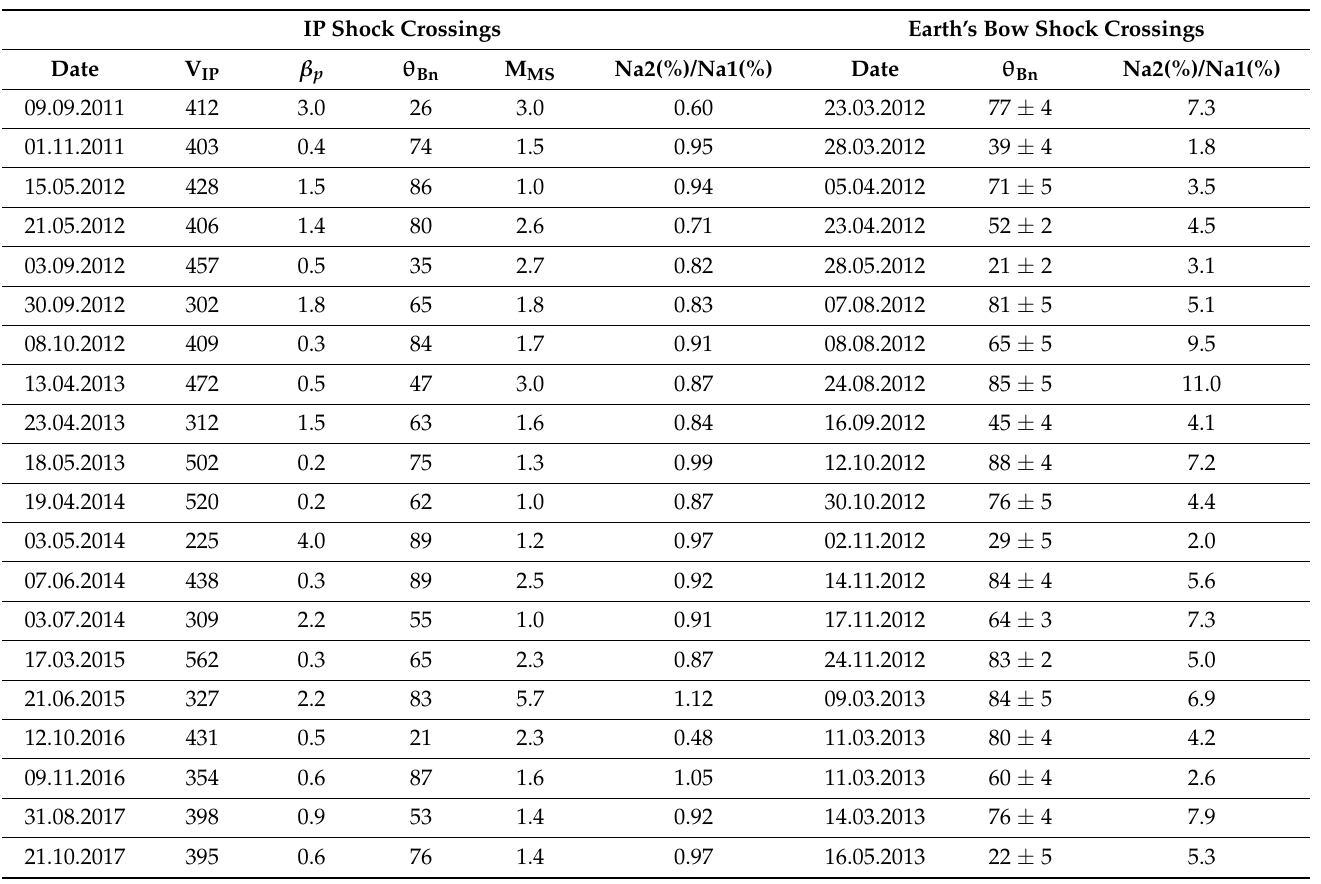
Table 1. Parameters for IP shock and Earth’s bow shock crossings.